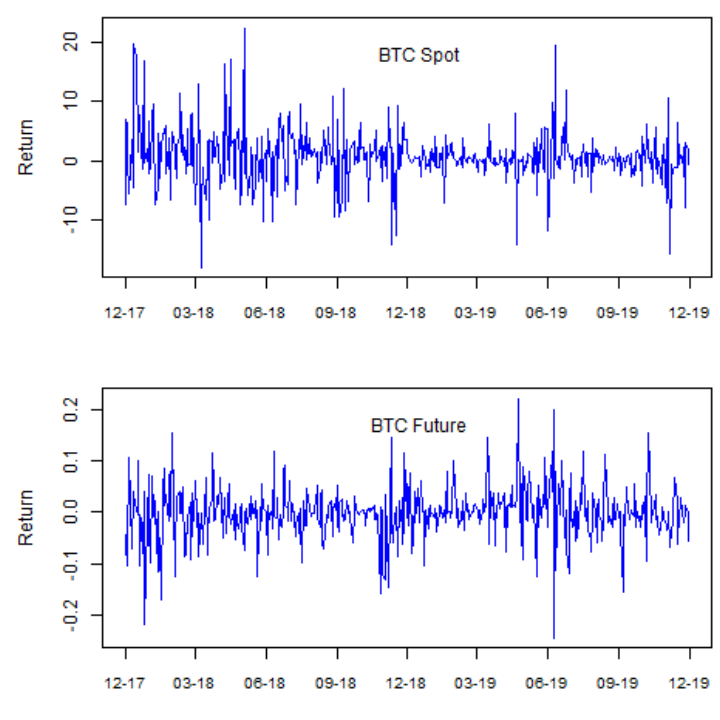
Figure 3. Bitcoin spot and futures